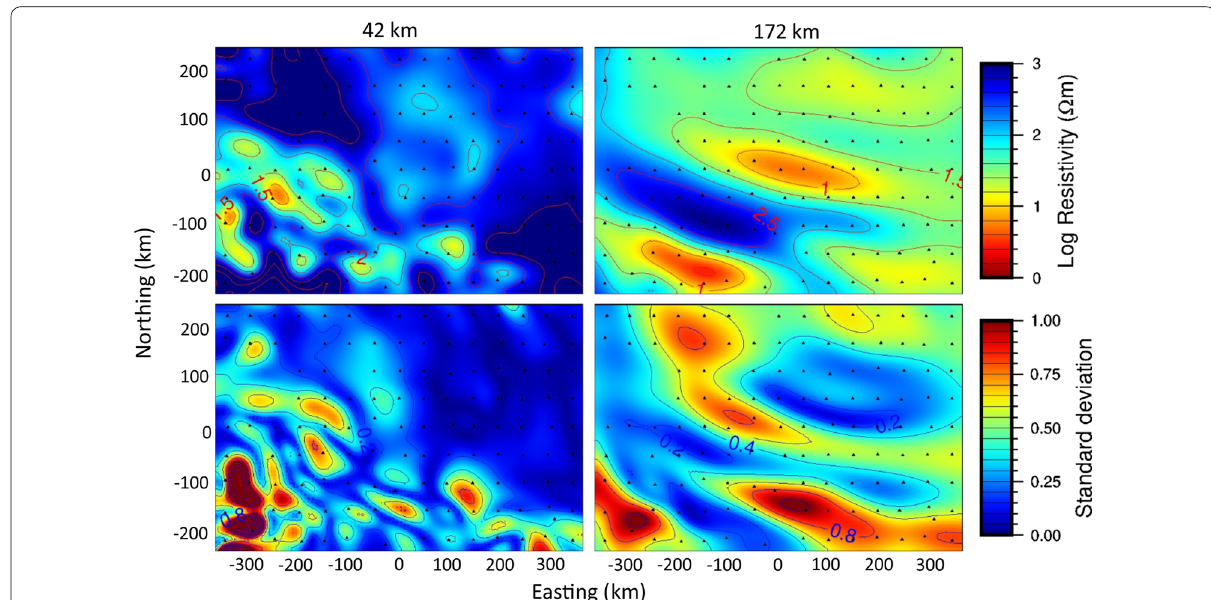
Fig. 11 Average and standard deviation of ModEM inversions with prior resistivities of 10, 31.6, 69, 100, 316 and 1000 (cid:31) m. Black triangles are locations of MT sites. A standard deviation of 0.2 at a certain point in the model means that 68% of the data lie within 0.2 log resistivity of the average value of that cell (averaged across all starting models). For example, average value at a point and then 68% of values lie within 0.2log (cid:31) m or between 1.8 and 2.2log (cid:31) m or between 65 and 160 (cid:31) m. The top row shows the average ± resistivity values (with 0.5 (cid:31) m contours), and the bottom row shows the standard deviation (with 0.2 contours)